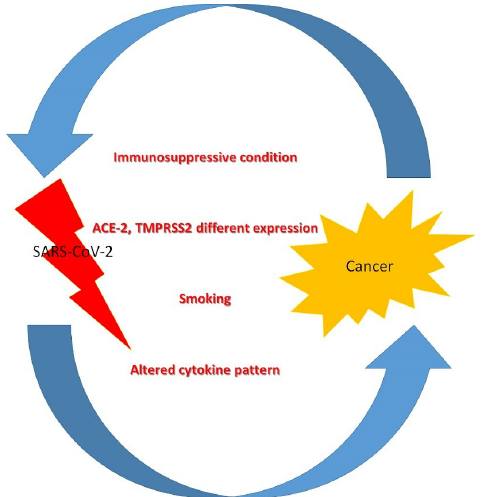
Figure 1. Pathophysiology of severe acute respiratory syndrome coronavirus 2 (SARS-CoV-2) infection in cancer